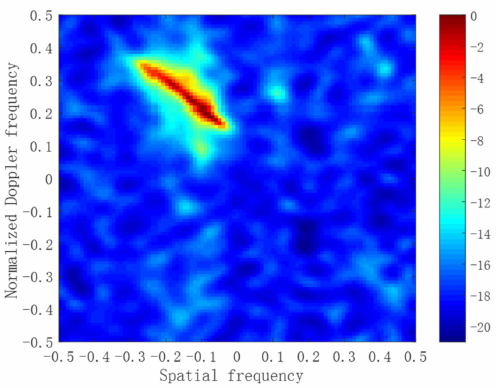
Figure 7. Estimated clutter Capon spectrum with all samples.